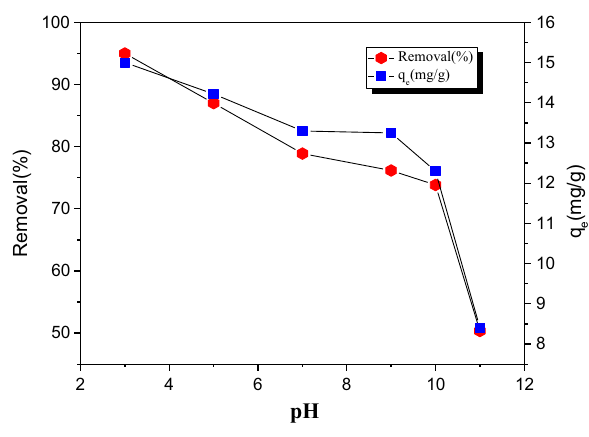
Fig. 3 Effect of pH on PC-G removal efficiency on MgO nanoparti- cles ( C 0 = 50 mg/L, dosage of 0.5 g/L, and time = 60